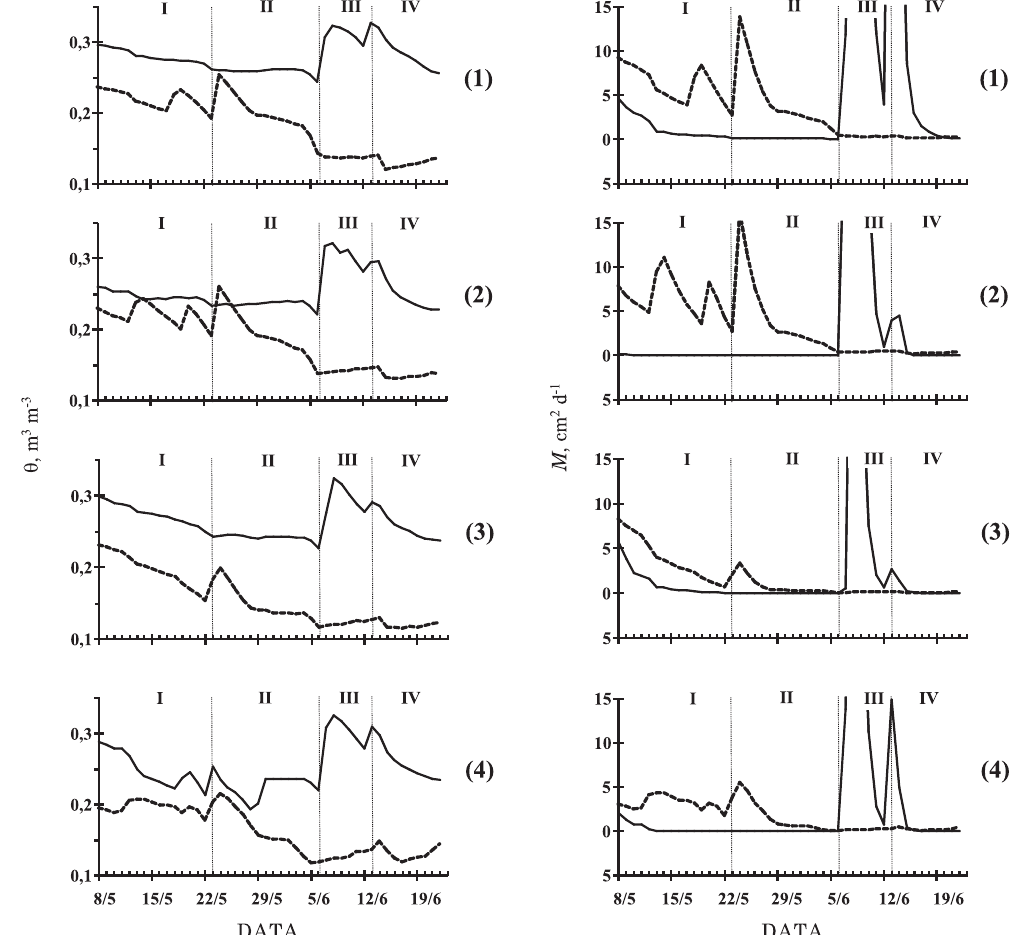
Figura 6. Teor de água ( θθθθθ ) e potencial de fluxo matricial ( M ) durante o período experimental em 2008 nos lisímetros 1, 2, 3 e 4. As linhas contínua e pontilhada representam o solo AG e AR,